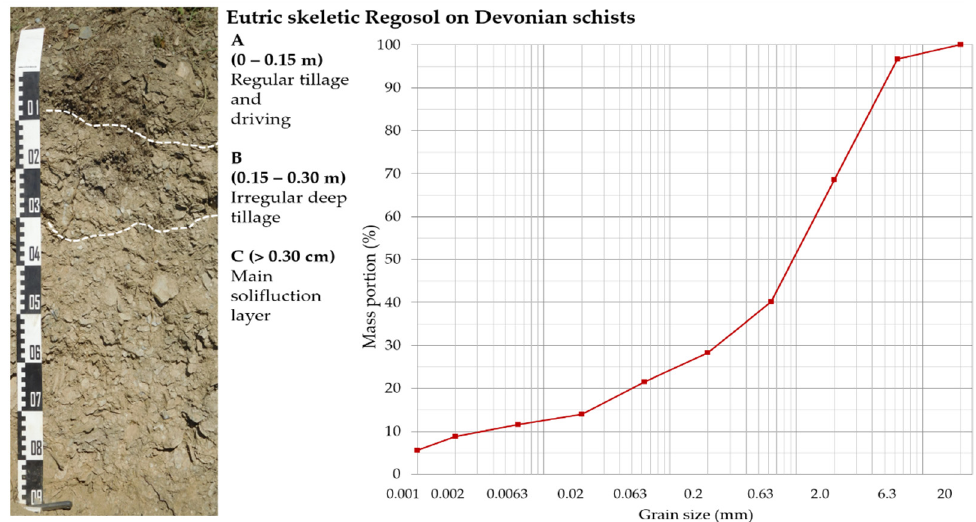
Figure 3. Characteristics of tested vineyard soils at study sites.